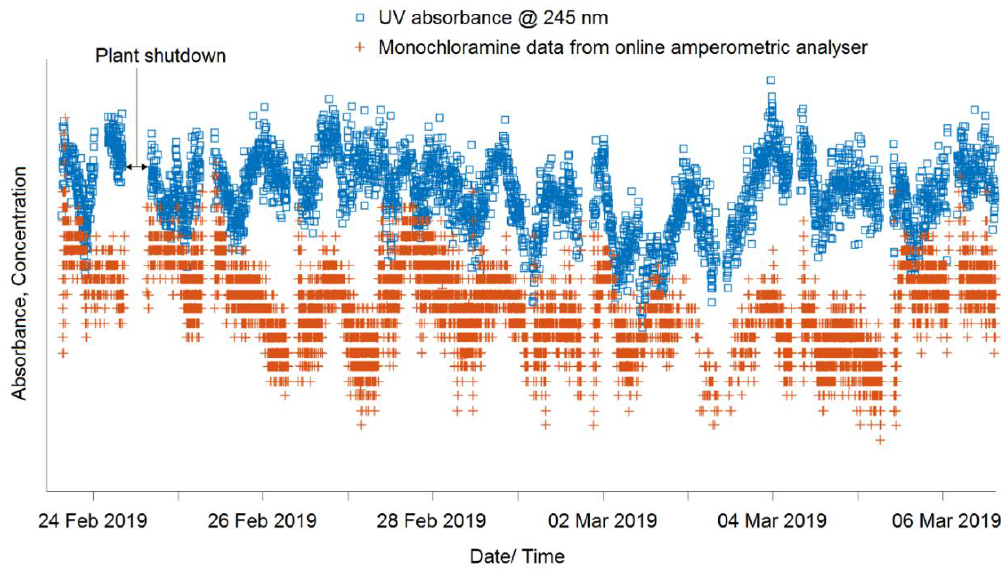
Figure 5. Alignment of monochloramine data with UV-Vis spectra.